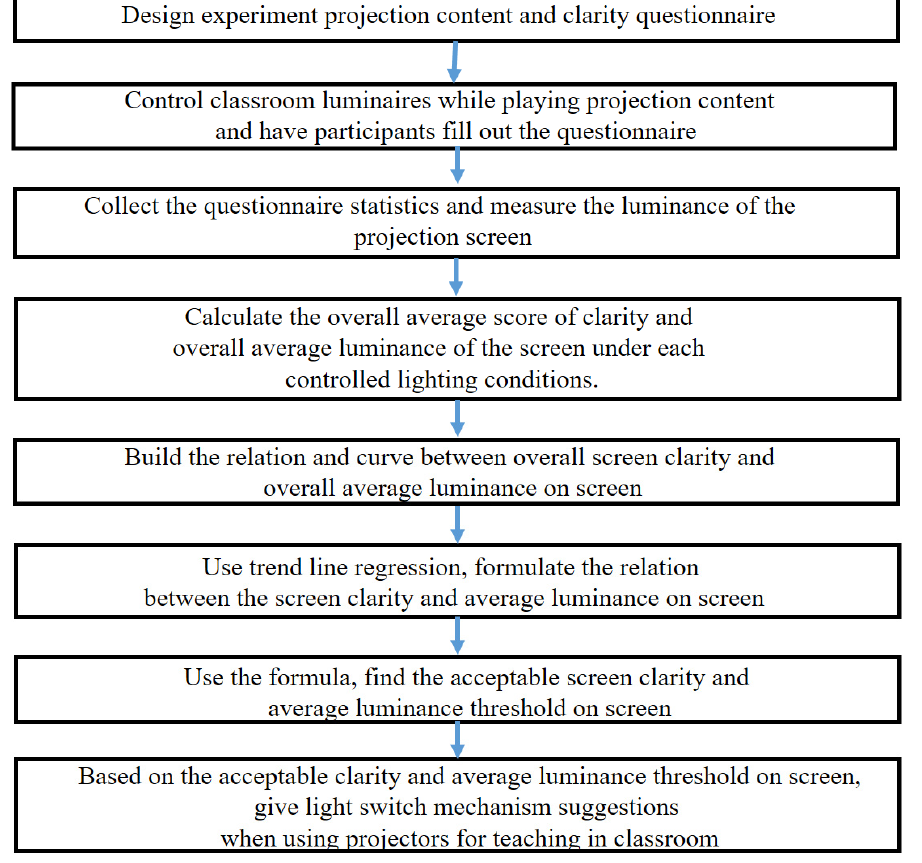
Figure 3. The flow chart for clarity study of the classroom projection screen.